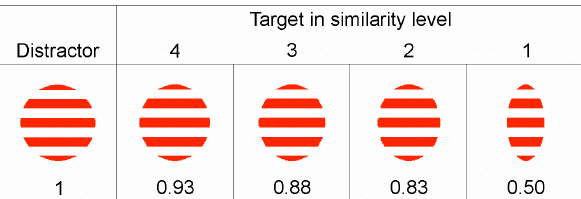
Figure 2. Target- and distractor-items in four levels of similarity. Numbers below items give the ratio of width to height and therefore the degree of target- distractor-similarity.